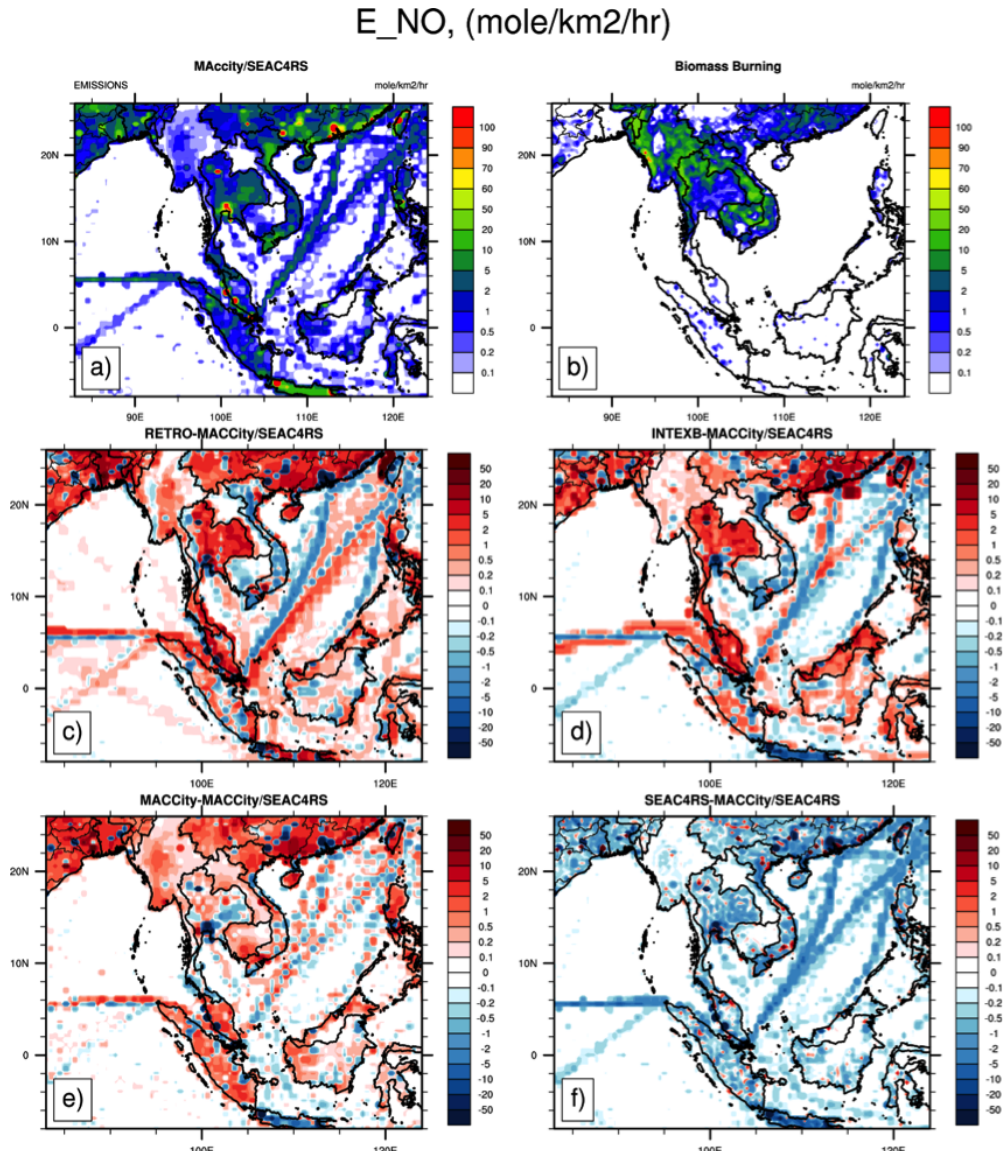
Figure 3. Nitrogen oxides emissions for March 2008 from different emission inventories: (a) MACCity–SEAC4RS, (b) biomass burning, (c) RETRO - MACCity–SEAC4RS, (d) INTEX-B - MACCity–SEAC4RS, (e) MACCity - MACCity–SEAC4RS, and (f) SEAC4RS - MACCity– SEAC4RS. (Table 1): power generation, industry, residential, and trans- portation. The uncertainty of the INTEX-B emissions for the Southeast Asian countries is estimated to be similar